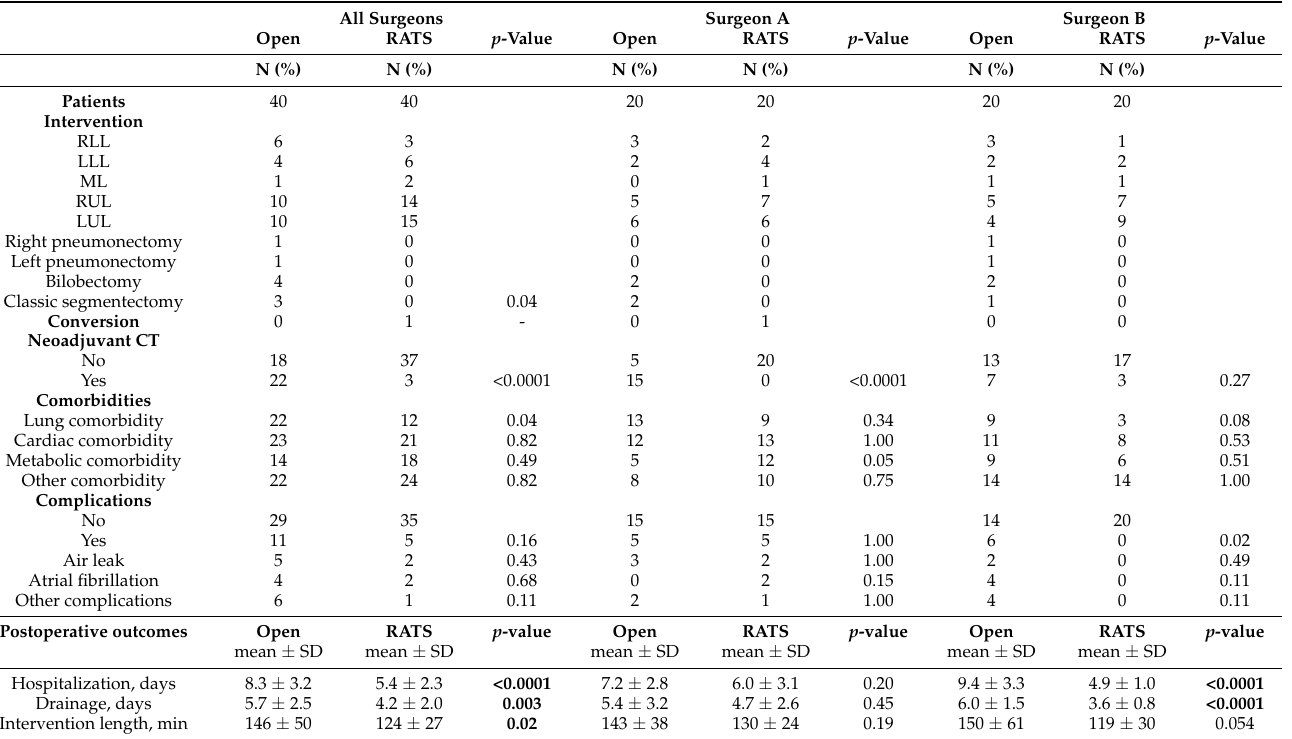
Table 1. Pre- and postoperative outcomes concerning the types of interventions, the clinical histories of the patients, and